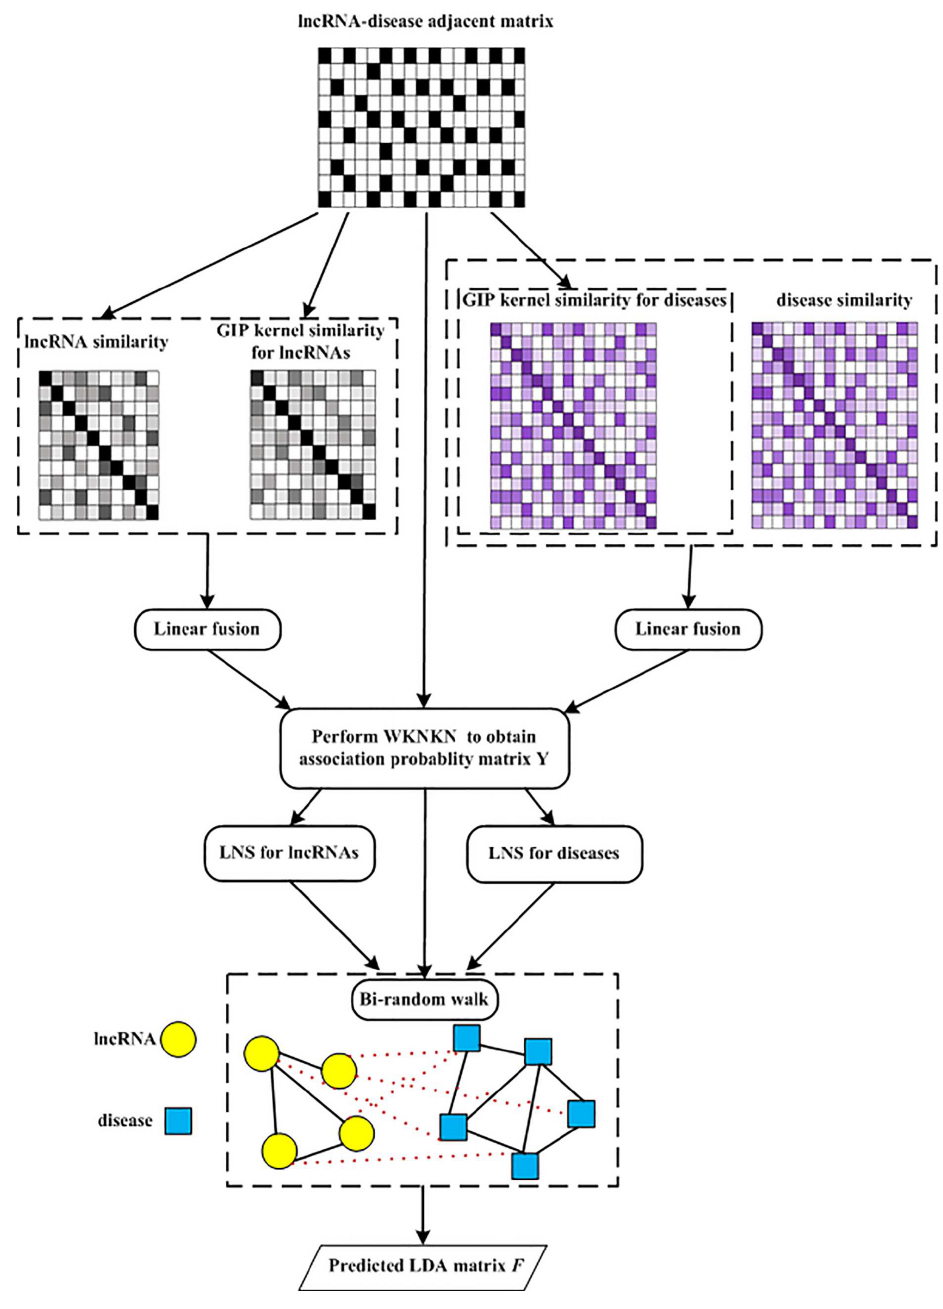
Figure 2. Flowchart of